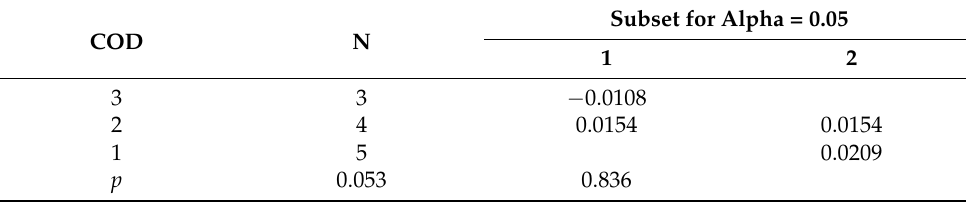
Table 3. Tukey HSD results from dorsal side data from samples pertaining to animals aged 0–8 months.